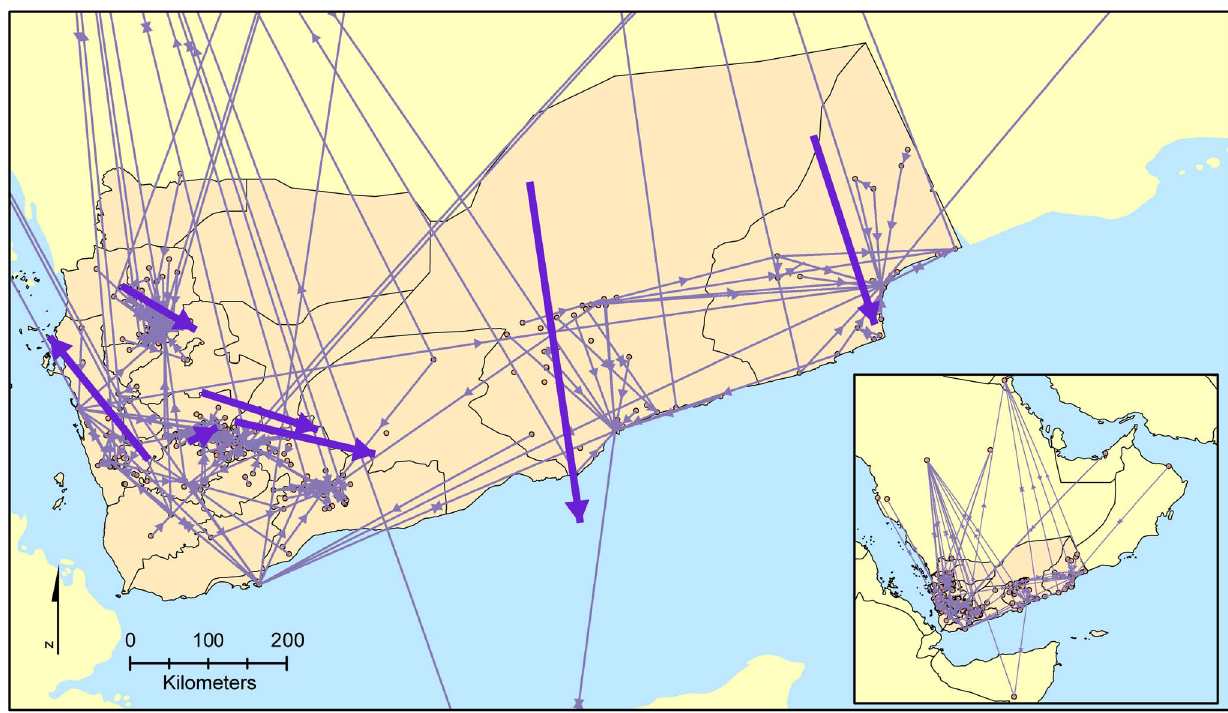
Figure 4. Migration direction vectors and mean migration direction by collection site over all three generations. Small arrows represent migration vectors and large arrows represent mean migration direction.